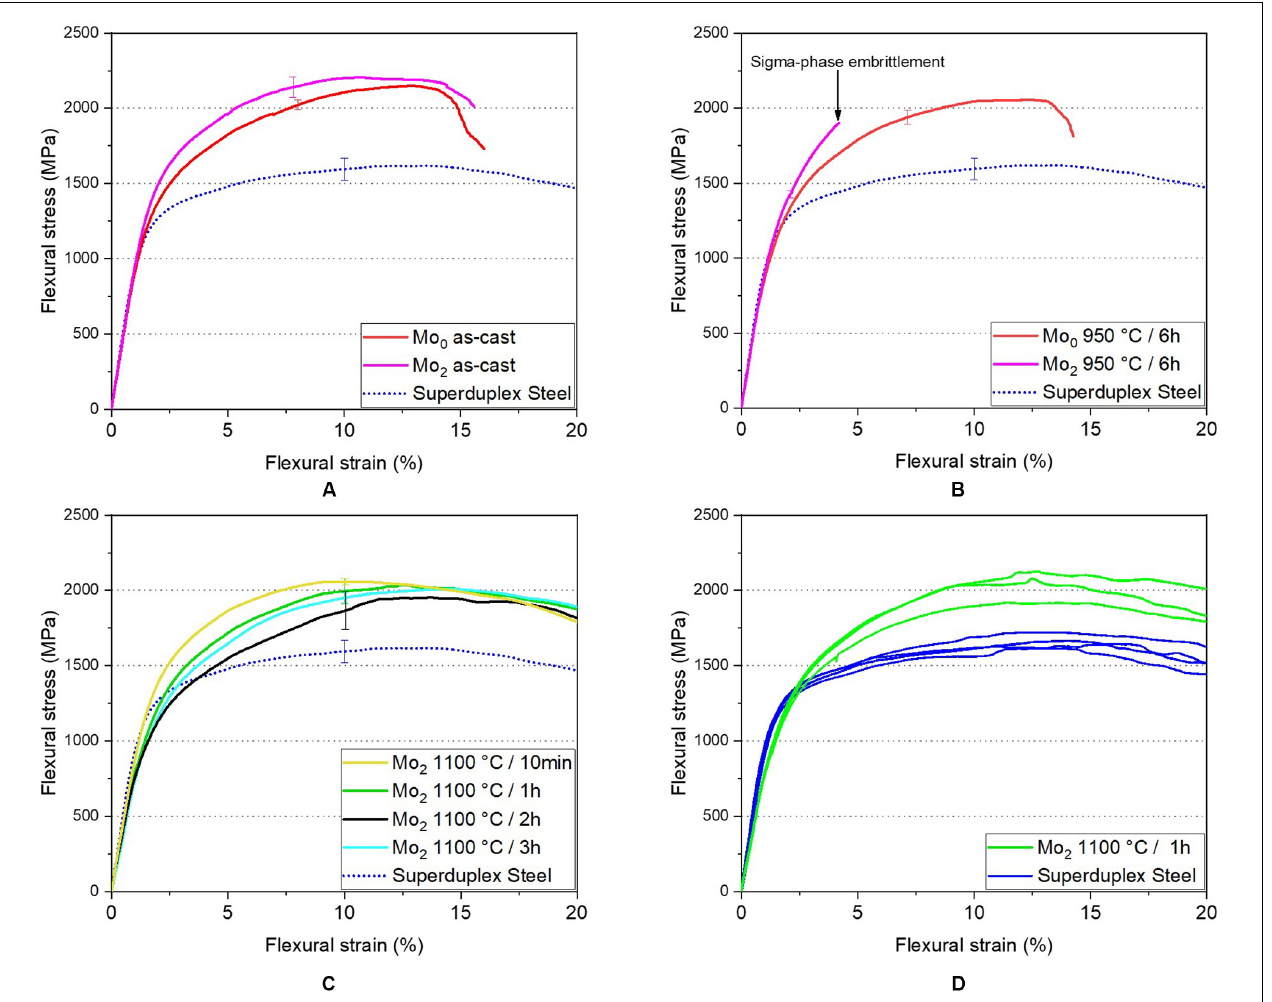
FIGURE 8 | (A) Flexural stress-strain curves in as-cast conditions: AlCrFe 2 Ni 2 (Mo 0 ) in red, AlCrFe 2 Ni 2 Mo 0 . 1 (Mo 2 ) in magenta, superduplex steel reference 1.4517 in blue, (B) after annealing at 950 ◦ C/6 h: Mo 0 in red, Mo 2 in magenta, (C) Mo 2 after annealing at 1100 ◦ C for 10 min (yellow), 1 h (green), 2 h (black), and 3 h (light blue). Illustration of the spread shown in (D) for Mo 2 1100 ◦ C/1 h and the reference superduplex